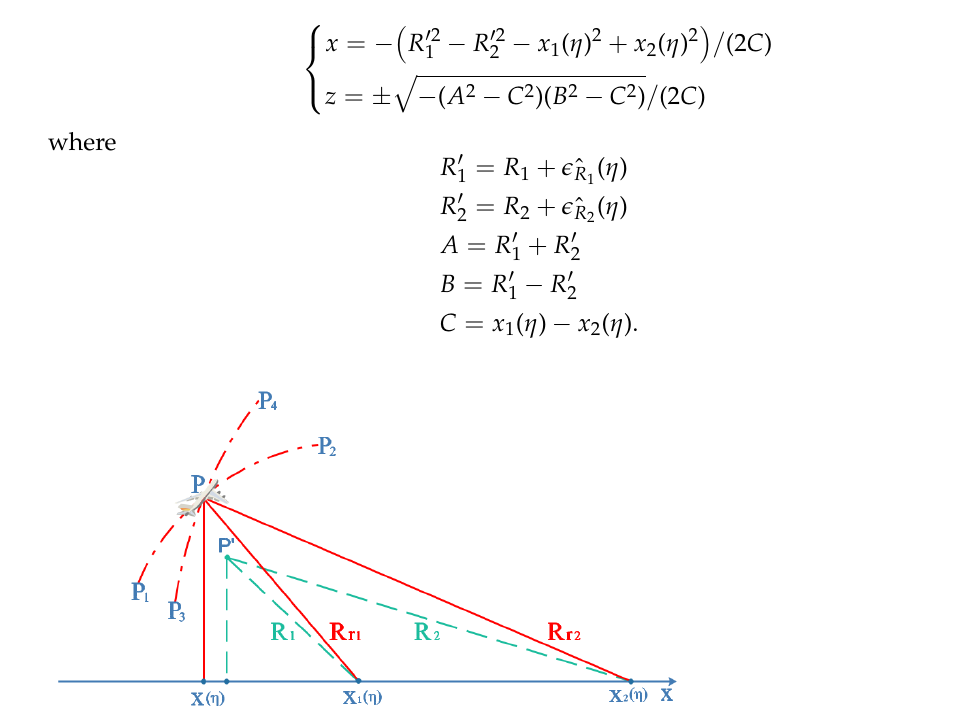
Figure 6. Geometric analysis for deriving the closed-form solution of ∆ x ( η ) and ∆ z ( η